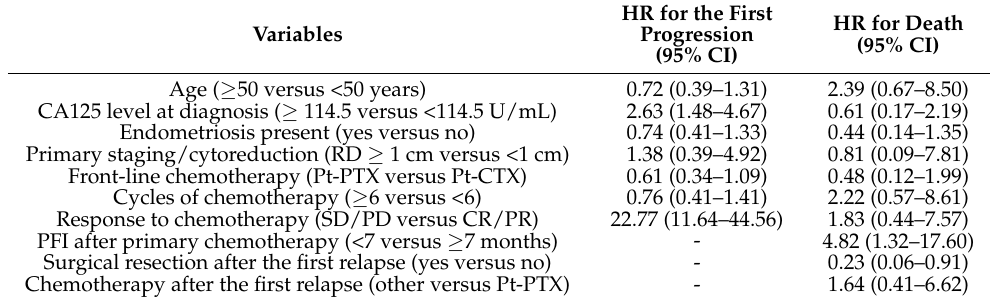
Table 5. Multivariate analysis of prognostic factors in early-stage OCCC patients ( n = 371).